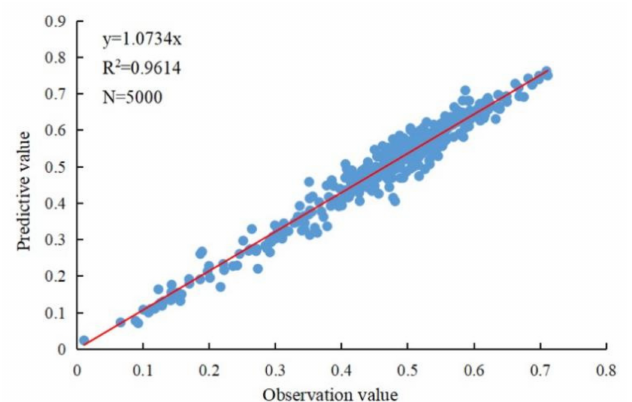
Figure 2. Correlation analysis between observed NDVI and predicted NDVI.